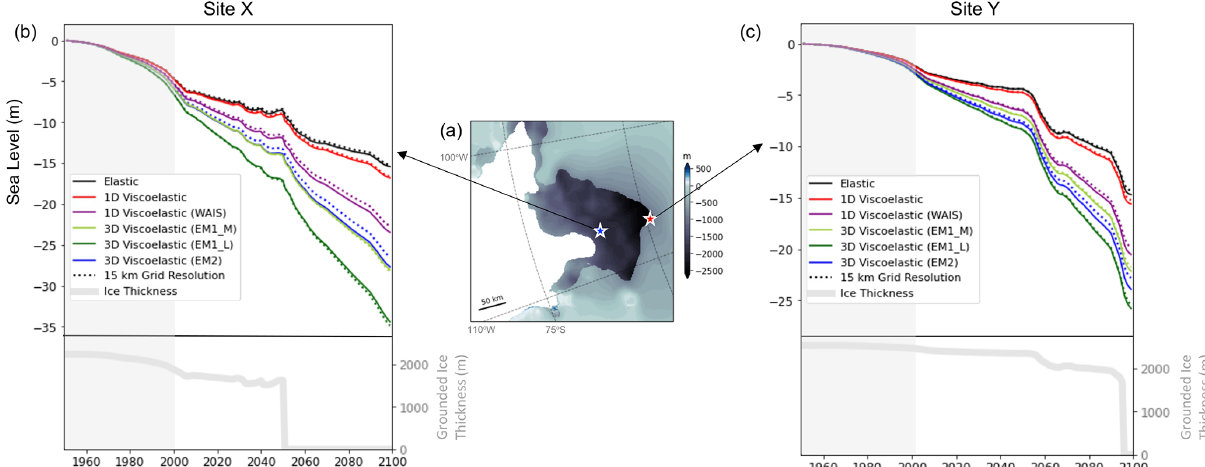
Figure 8. Evolution of site-specific sea level in simulations adopting a range of model resolutions and Earth models. (a) Ice thickness change from 2000 to 2100 predicted in the ICE-RD simulation. This panel is identical to Fig. 2c. (b) Coloured lines show predicted sea-level change, in metres, at Site X that experiences the maximum viscous uplift in the 1.9km resolution simulation, shown by the blue star in panel (a) . Each coloured line represents, respectively, the simulations with a purely elastic solid Earth response (black lines), viscoelastic solid Earth response based on a global average 1-D Earth model (red lines), a 1-D Earth model best-fit for the WAIS from Powell et al. (2022) (purple lines), a low-viscosity 3-D Earth model EM1_L (dark green lines), a moderate-viscosity 3-D Earth model EM1_M (light green lines) and 3-D viscosity Earth model EM2 (blue lines). Solid lines are for simulations performed at 1.9km resolution, and dashed lines adopt a 15km resolution. The thick gray line represents the evolution of grounded ice thickness at the respective sites. Panel (c) is as in panel (b) but for Site Y along the final grounding-line position at 2100 that experiences the greatest ice thickness change, labelled by the red star in panel (a)